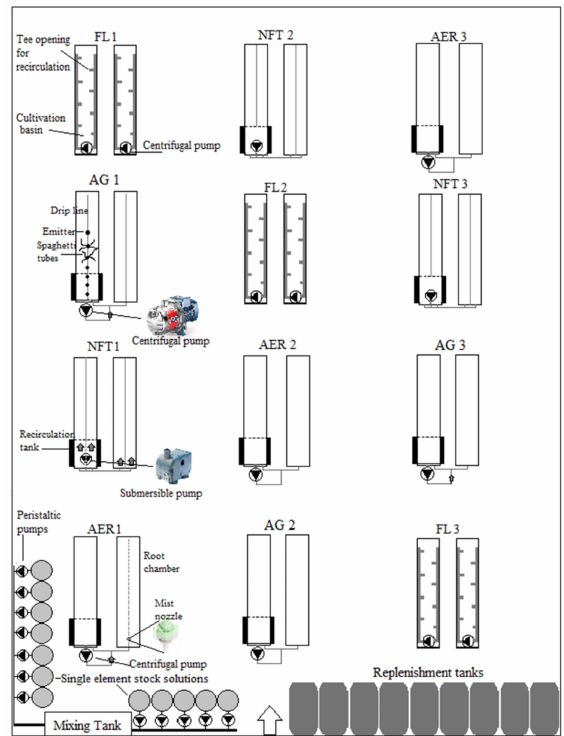
Figure 1. Layout of the 12 experimental units; aeroponic (AER i ), floating (FL i ), nutrient film technique (NFT i ), and aggregate (AG i ) I = 1, 2, 3